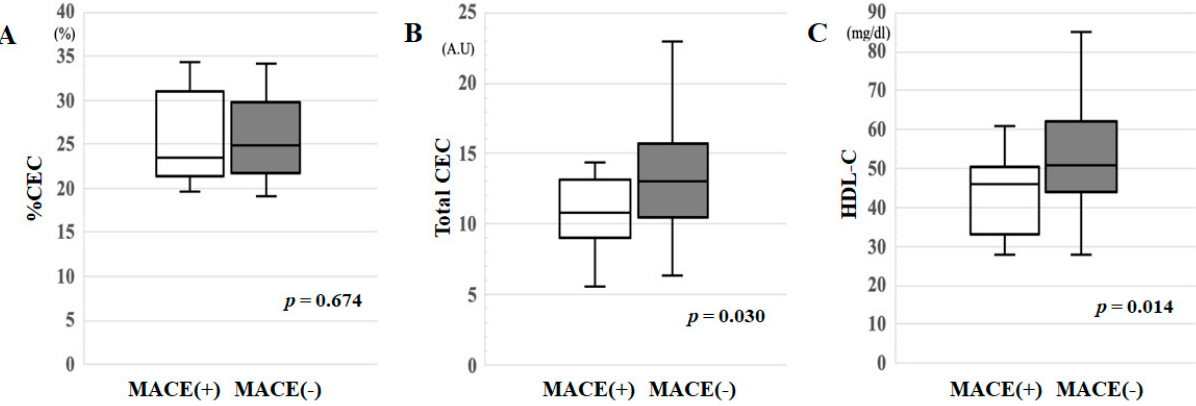
Figure 1. ( A ) %CEC, ( B ) total CEC and ( C ) HDL-C in the MACE(+) and MACE( − ) groups. A.U : arbitrary unit.